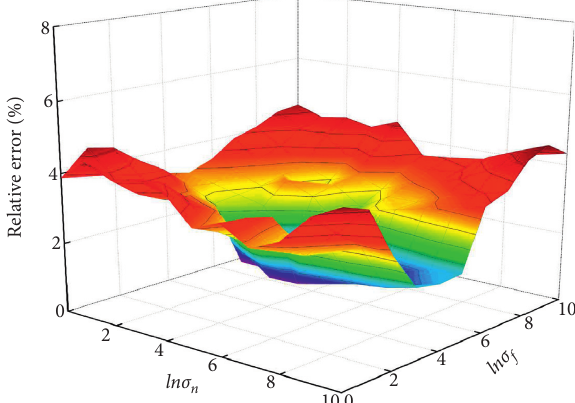
Figure 14: The influence of σ